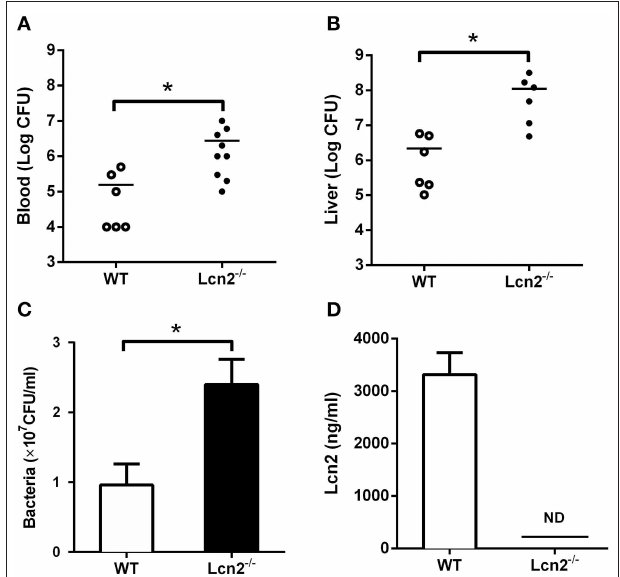
FIGURE 2 | The bacteriostatic characteristics of lipocalin 2 (Lcn2). (A,B) Bacterial loads in blood (CFU/ml) and livers (CFU/mg) of E. coli O157:H7-infected mice 32 hpi. (C,D) Serum levels of Lcn2 protein measured and growth of E. coli O157:H7 in RPMI with 20% acute-phase serum from wild-type (WT) or Lcn2 − / − mice. Values are average means of triplicate experiments with two mice per genotype per experiment. Error bars depict SEM ( n = 6 per group). Results are expressed as means ± SEM. P < 0.05 was considered statistically significant. * P <